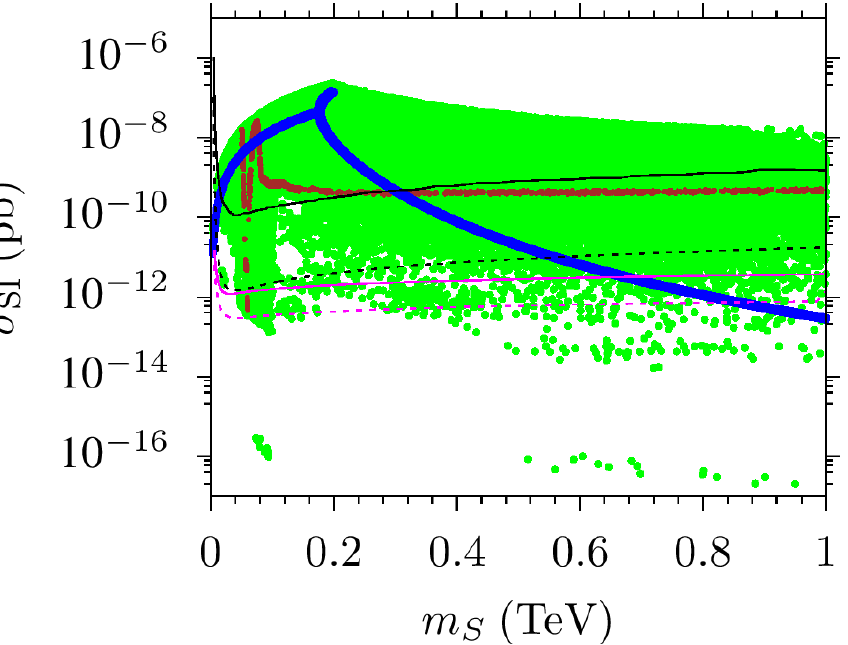
Figure 6. Variation of the dark matter–nucleon spin-independent cross section with the dark matter mass ( m S is the same as M H (cid:48) ). The scan of the parameter space gives a relatively wide region (green) but the naturalness condition in (43) restricts allowed range to the blue domain. The blue cross section is seen to fall with m (cid:48) in accordance with (43) according to which the heavier the H (cid:48) the H smaller its cross section. The negative results at dark matter direct searches may be an indication of the naturally coupled nature of the dark matter. (taken from [38], with the permission of the